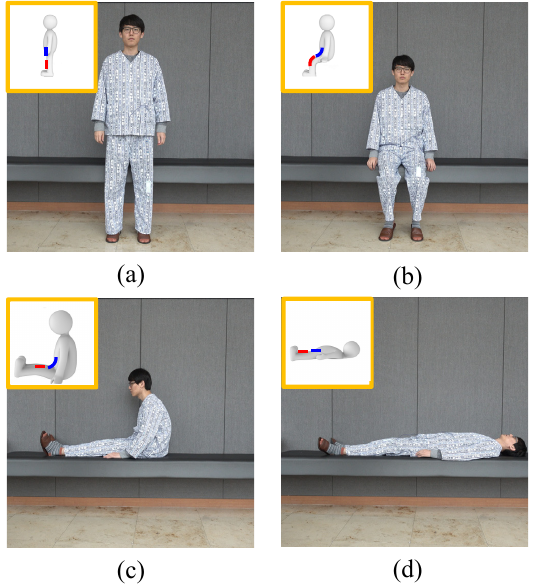
Figure 4. Patient postures with the ( a ) standing; ( b ) sitting; ( c ) sitting knee extension; and ( d ) supine positions. In the inset, the red and blue lines are the sensor shapes at the knee and hip, respectively.